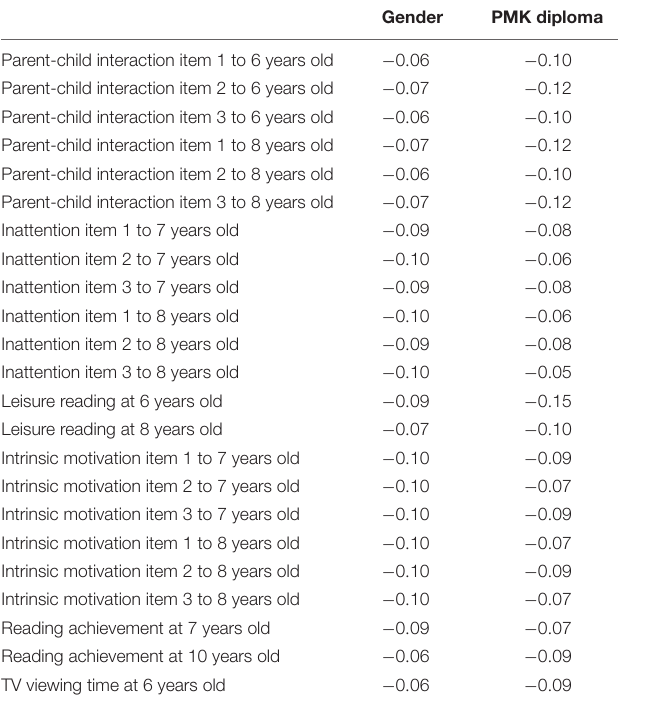
TABLE 4 | Correlations between not answering one of these variables with gender and the PMK diploma (0 = answer provided and 1 = no answer). Gender PMK